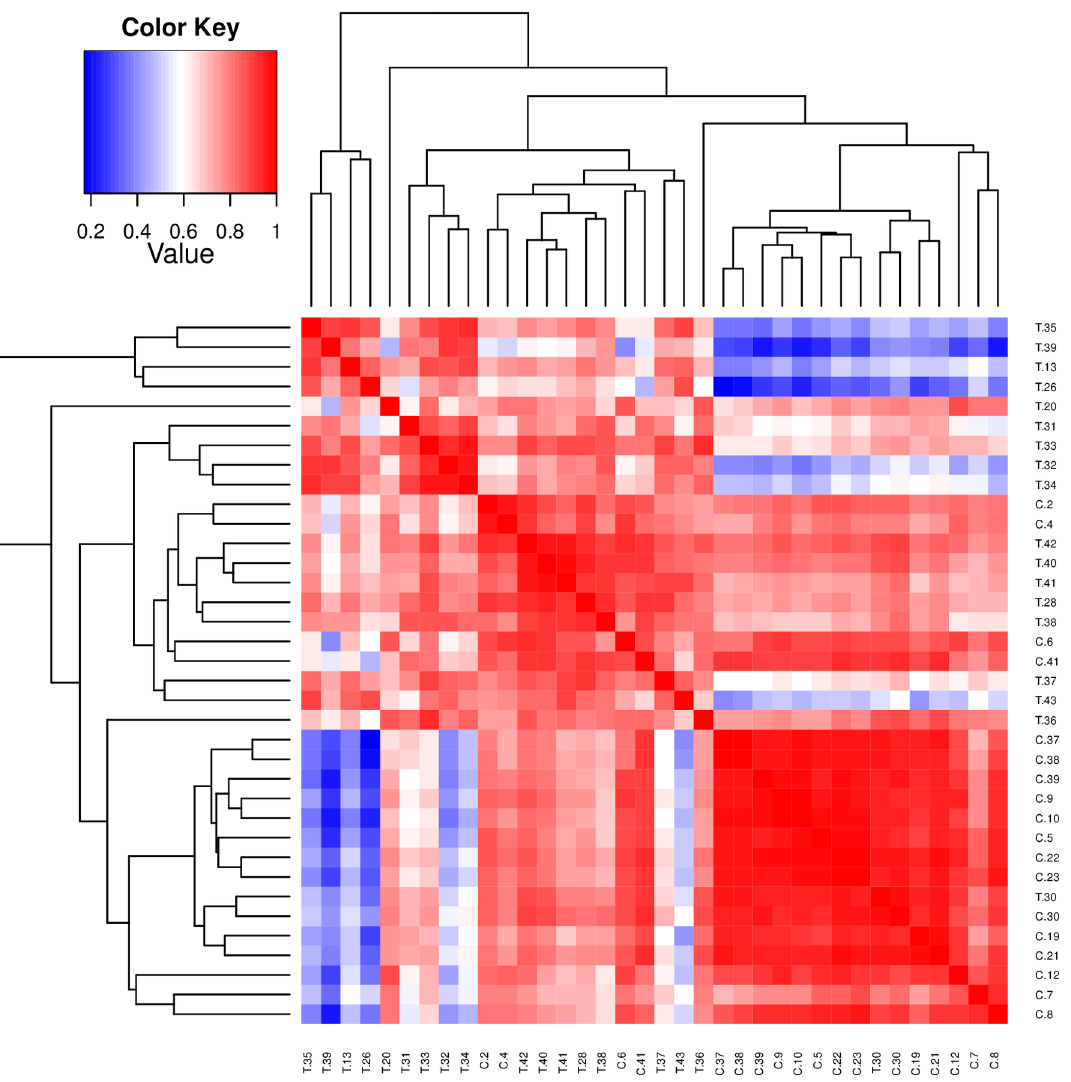
Fig 5. Sample-Sample correlation hear map for lipidomics data obtained. Clustering on correlation coefficients clearly demonstrates samples group (tumor or normal) based on the abundance levels of differential